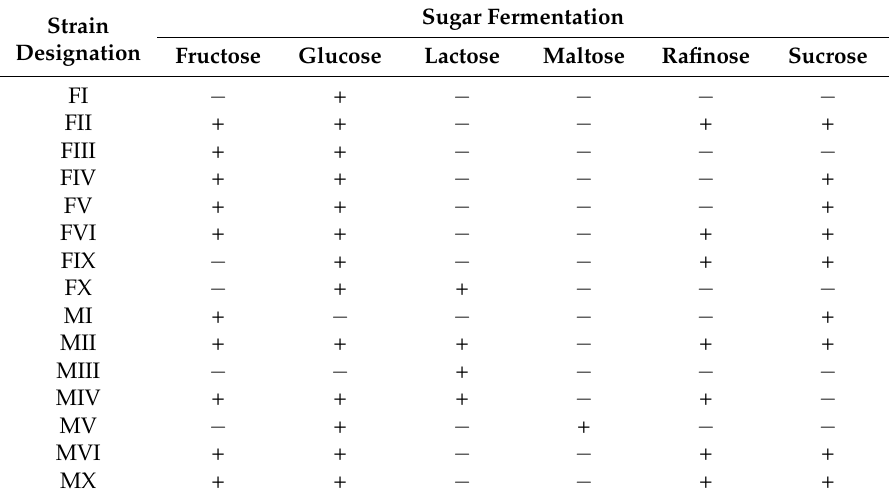
Table 2. Fermentation of different carbohydrates by selected S. cerevisiae flor yeasts, analyzed with microtiter technology. Values are expressed as (+) if yeast strains were able to ferment the carbon/nitrogen source and ( − ) if yeast strains were not able to ferment them.